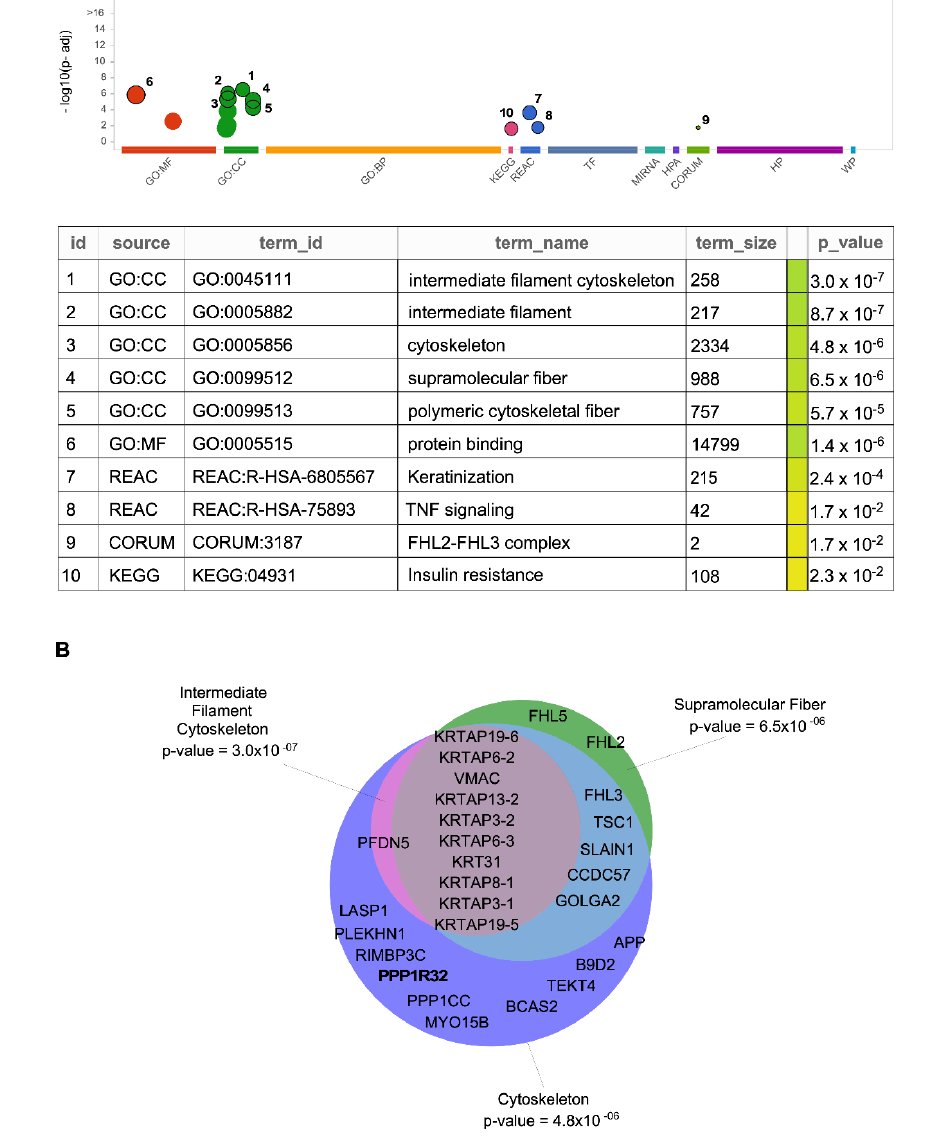
Figure 2. IIIG9 interactors obtained from BioGRID grouped by biological process. ( A ). Manhattan plot of g: Profiler for IIIG9 interactors: the x-axis shows functional groups by data source (Gene Ontology (GO): Molecular Function, Cellular component, Biological Process; Kyoto Encyclopedia of Genes and Genomes (KEGG); Reactome (REAC); Protein complex (CORUM)) and the y-axis shows the significance in each group. The p -values in the table indicate low (yellow) and high (blue) significance. ( B ). Venn diagram indicates the subcellular localization of IIIG9 interactors, with respective p -values [42] .